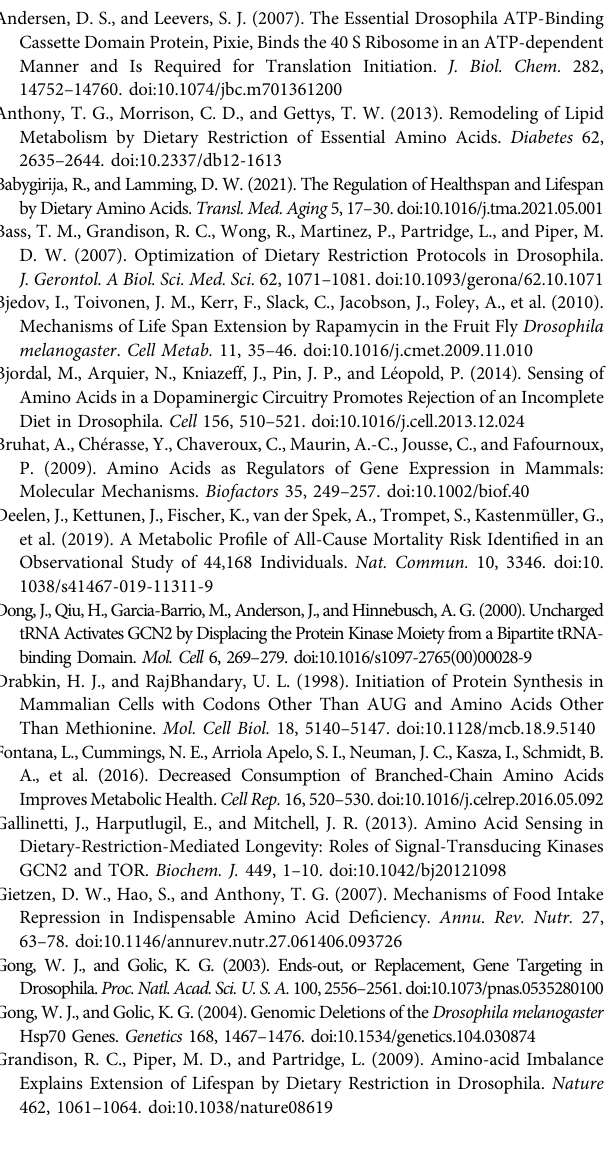
Supplementary Figure S5 | Transcriptional pro fi ling identi fi es diet and GCN2 dependent changes. (A) Venn diagram representation of the overlap of upregulated and downregulated gene sets between w Dah controls and the Gcn2 1 mutants under each diet. Overlaps were signi fi cant for all diets: upregulated: -R, p = 1.8 × 10 − 148 , -M, p = 0, -All, p = 0; downregulated: -R, p = 1.5 × 10 − 38 , -M, p = 6.8 × 10 − 26 , -All, p = 3.9 × 10 − 153 , Fisher ’ s exact test. (B) Venndiagramrepresentationofdifferentiallyexpressedgenesof w Dah controlsand Gcn2 1 mutants overlapping with ATF4-target genes. Overlaps were signi fi cant for